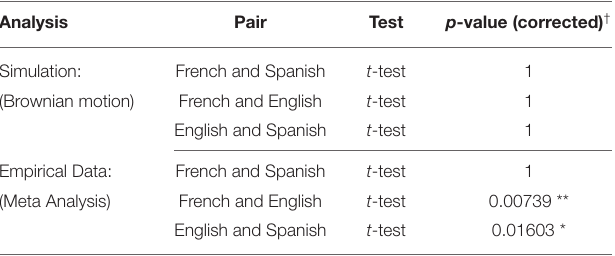
TABLE 2 | Results of statistical significance tests (for three selected languages).